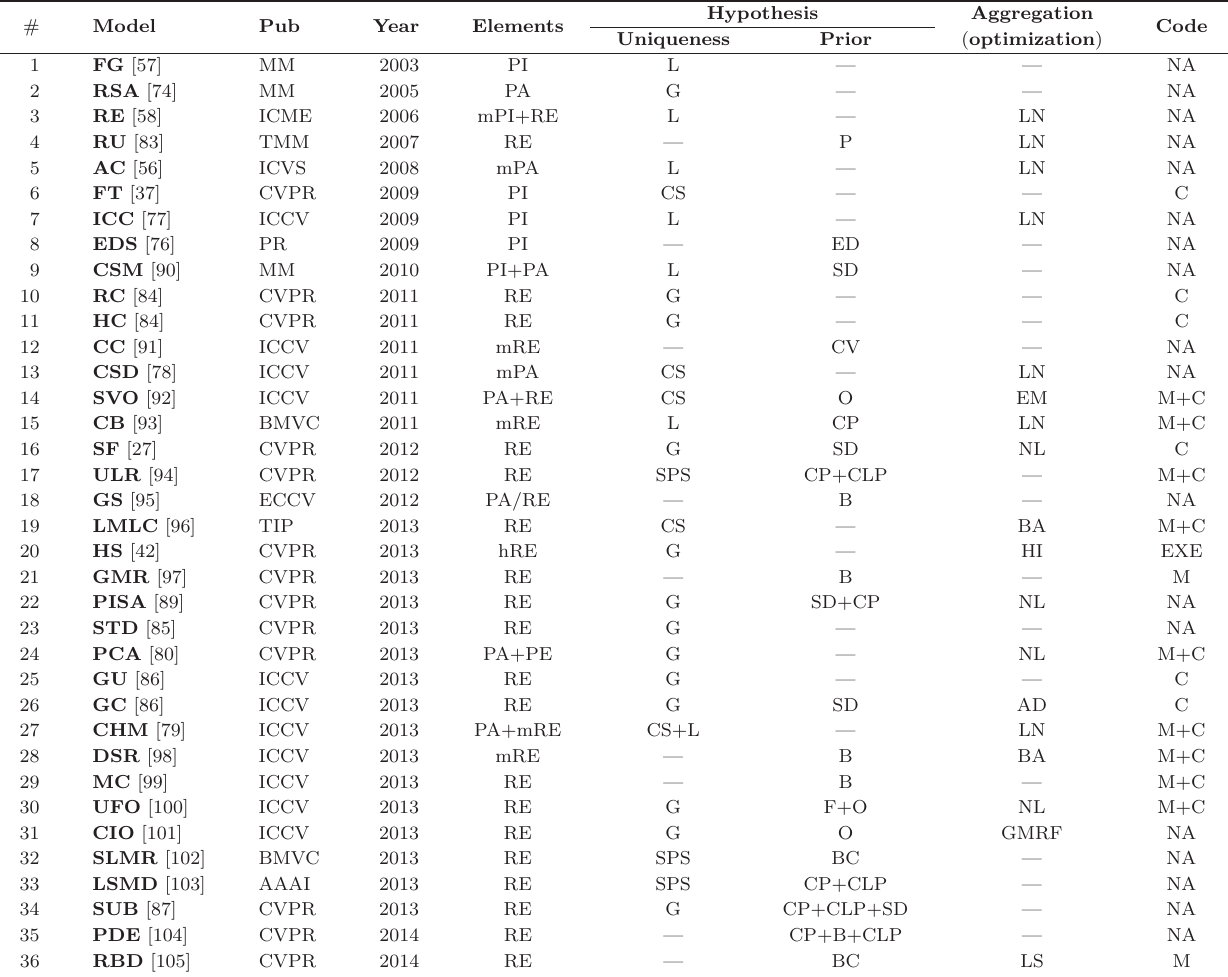
Table 1 Salient object detection models with intrinsic cues (sorted by year). Elements: { PI = pixel, PA = patch, RE = region } , where prefixes m and h indicate multi-scale and hierarchical versions, respectively. Hypothesis: { CP = center prior, G = global contrast, L = local contrast, D = edge density, B = background prior, F = focus prior, O = objectness prior, CV = convexity prior, CS = center-surround contrast, CLP = color prior, SD = spatial distribution, BC = boundary connectivity prior, SPS = sparse noise } . Aggregation/optimization: { LN = linear, NL = non-linear, AD = adaptive, HI = hierarchical, BA = Bayesian, GMRF = Gaussian MRF, EM = energy minimization, and LS = least-square solver } . Code: { M= Matlab, C= C/C++, NA = not available, EXE = executable